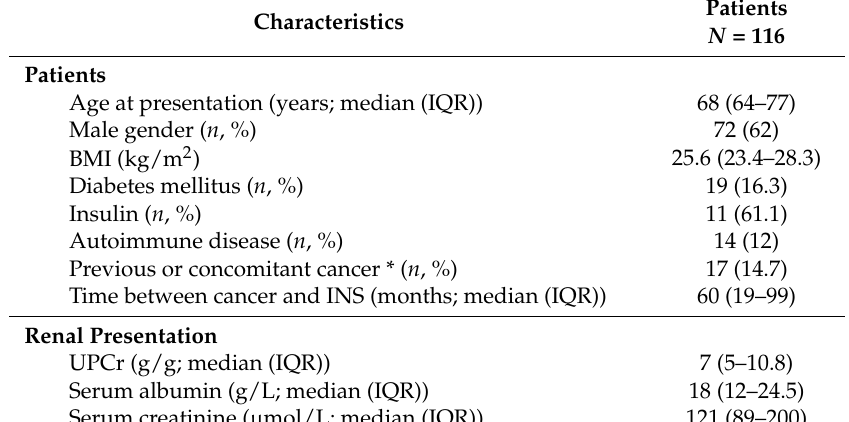
Table 1. Characteristics of Presentation of 116 Older Patients with Idiopathic Nephrotic Syndrome. MCD, minimal change disease; FSGS, focal and segmental glomerulosclerosis. * Cancer diagnosed up to 6 months after presentation was considered as previous or concomitant to the